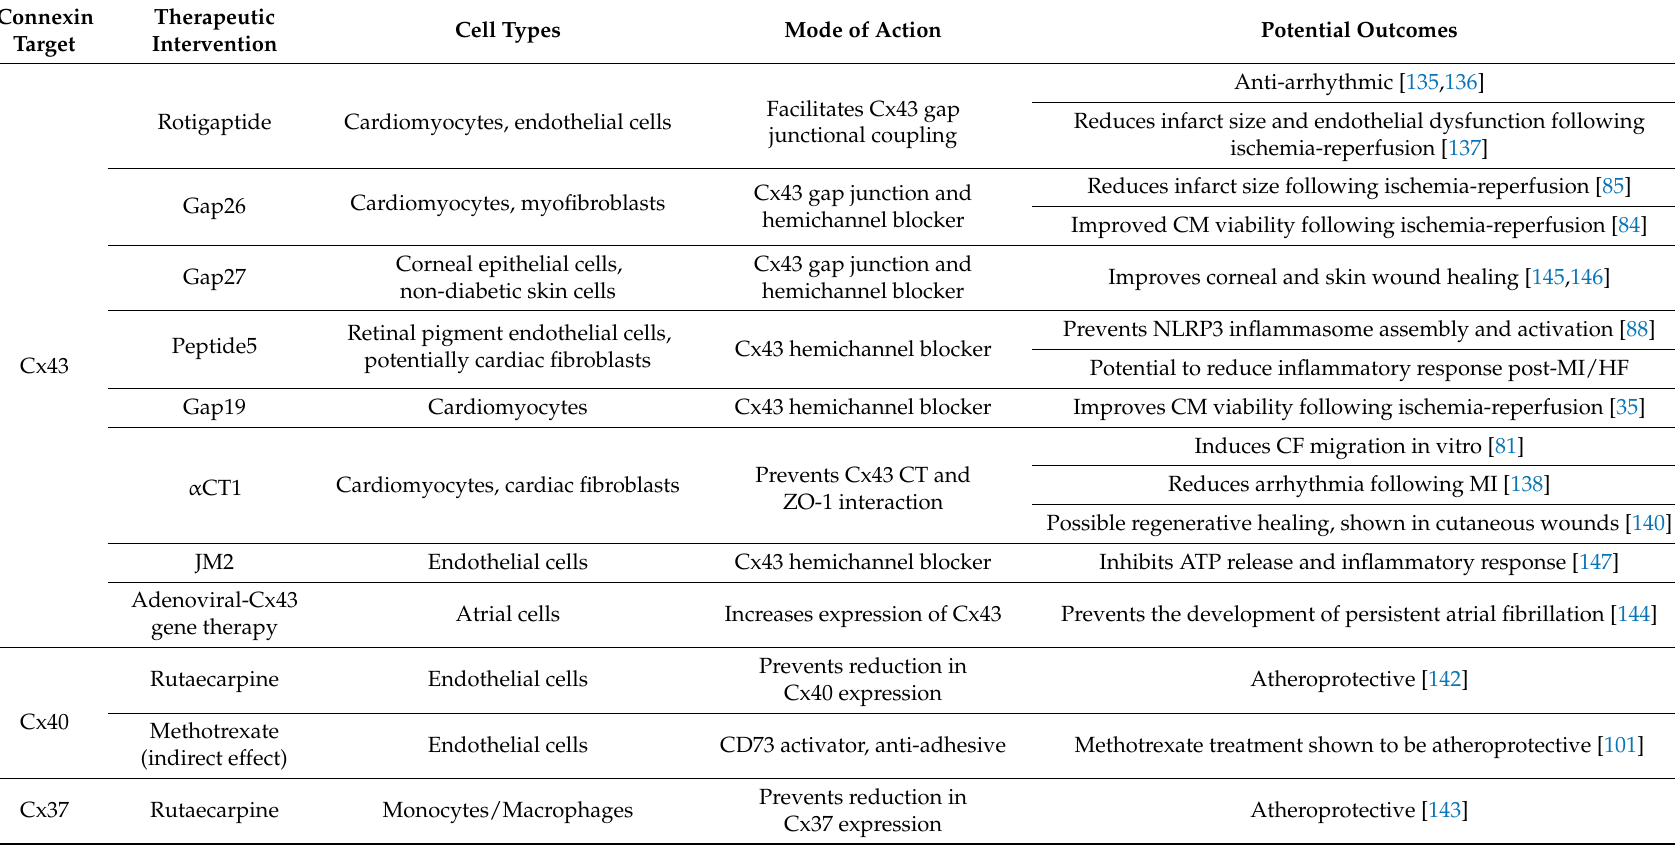
Table 1. Potential non-myocyte connexin